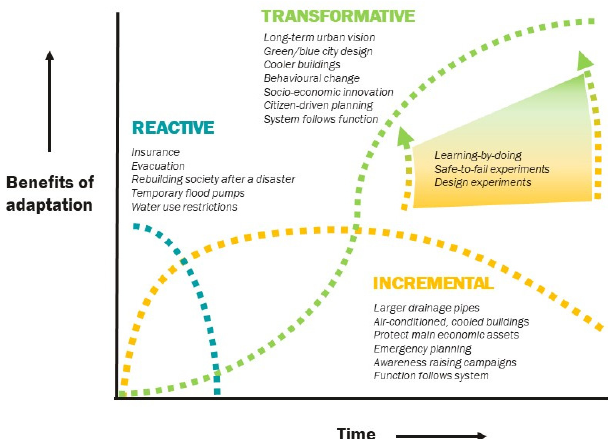
Figure 1. Some examples of reactive, incremental, and transformative adaptation strategies for urban land-use policy development (C40/CAS 2020).